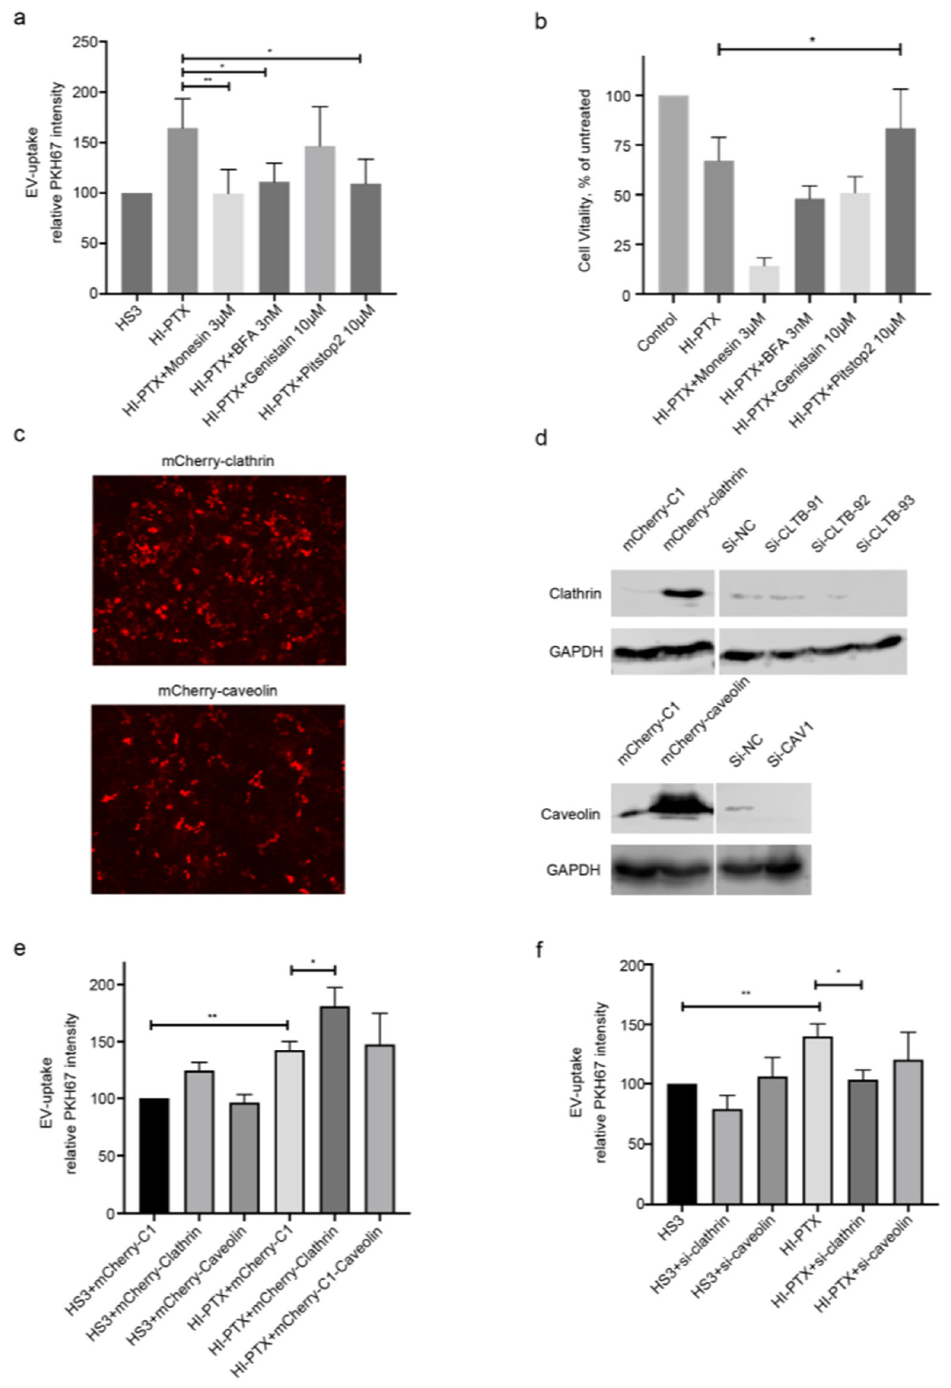
Figure 4. HI-PTX’s uptake and cytotoxicity is associated with clathrin-mediated endocytosis. ( a ) The Figure 4. HI ‐ PTX’s uptake and cytotoxicity is associated with clathrin ‐ mediated endocytosis. ( a ) The clathrin-mediated endocytosis inhibitor Pitstop2 inhibited the uptake of HI-PTX by PANC-1 cells; clathrin ‐ mediated endocytosis inhibitor Pitstop2 inhibited the uptake of HI ‐ PTX by PANC ‐ 1 cells; ( b ) Treatment with Pitstop2 attenuated HI ‐ PTX’s cytotoxicity in PANC ‐ 1 cells; ( c ) Overexpression ( b ) Treatment with Pitstop2 attenuated HI-PTX’s cytotoxicity in PANC-1 cells; ( c ) Overexpression of of clathrin and caveolin (Nikon TE2000 ‐ E, 10× magnification); ( d ) Knockdown of clathrin and cave ‐ clathrin and caveolin (Nikon TE2000-E, 10 × magnification); ( d ) Knockdown of clathrin and caveolin olin expression in PANC ‐ 1 cells, evidenced by fluorescent images and Western blot analysis, expression in PANC-1 cells, evidenced by fluorescent images and Western blot analysis, mCherry- mCherry ‐ clathrin, 63 kDa; clathrin, 31 kDa; mCherry ‐ caveolin, 53 kDa; caveolin, 22 kDa; ( e , f ) The clathrin, 63 kDa; clathrin, 31 kDa; mCherry-caveolin, 53 kDa; caveolin, 22 kDa; ( e , f ) The uptake uptake efficiency of HI ‐ PTX was altered by overexpression or knockdown of clathrin in pancreatic efficiency of HI-PTX was altered by overexpression or knockdown of clathrin in pancreatic cancer cancer cells. ** p < 0.01, * p < 0.05, one ‐ way ANOVA followed by Dunnett’s post ‐ test (data from three cells. ** p < 0.01, * p < 0.05, one-way ANOVA followed by Dunnett’s post-test (data from three individual determinations). individual